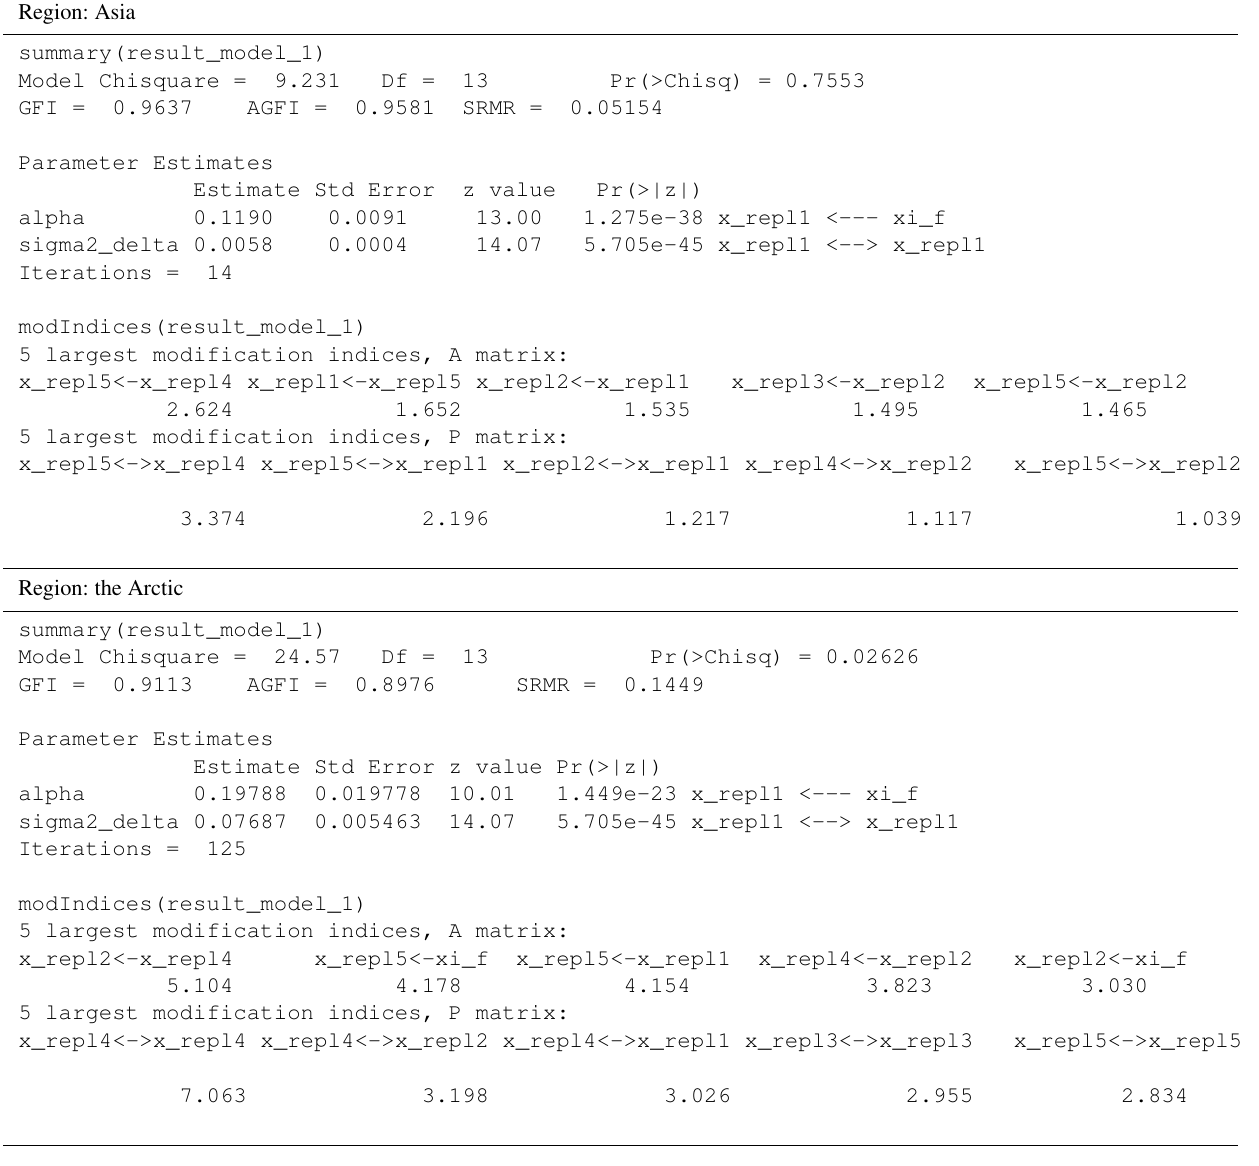
Table 3. (A part of) Outputs produced by the R package sem as a result of fitting the CFA(5, 1) model from Eq. (18) to two x Volc ensembles belonging to the region Asia and the Arctic,